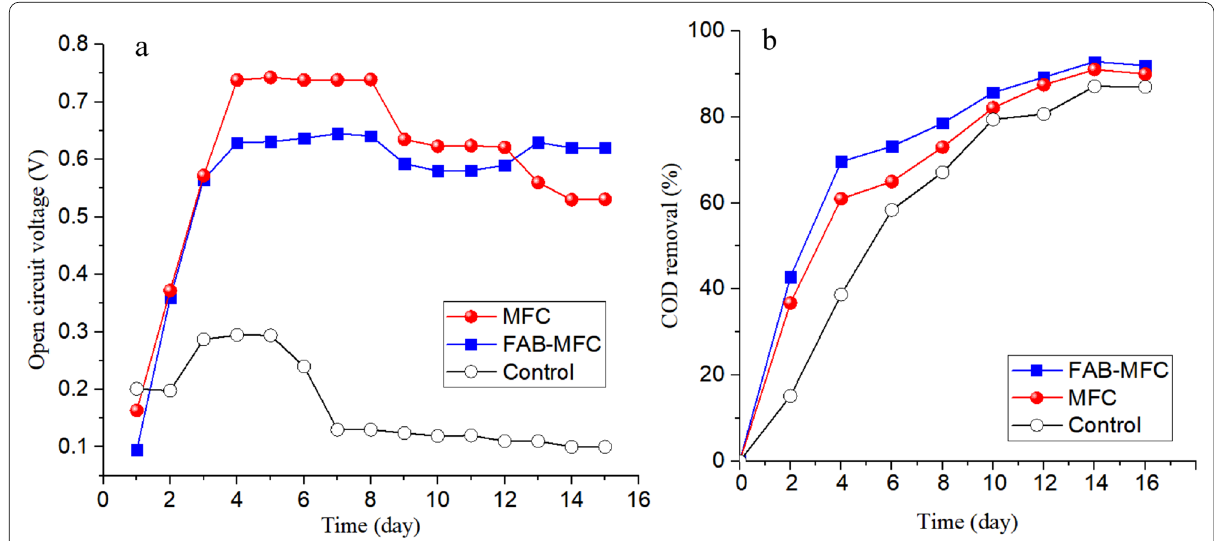
Fig. 10 Bench-scale a voltage output and b COD removal during the study